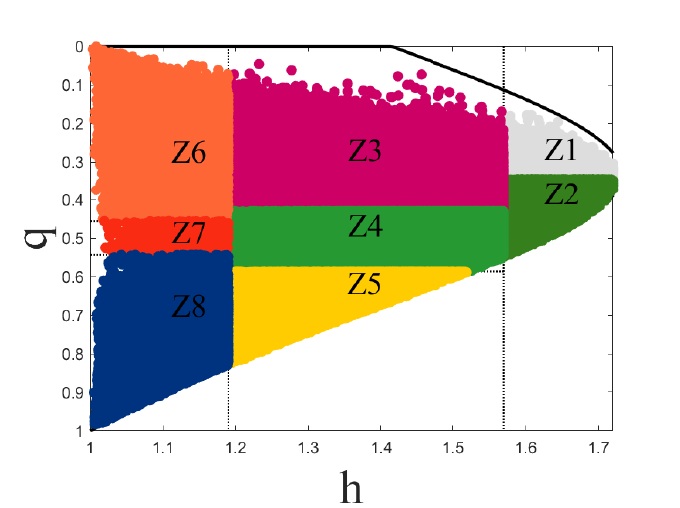
Figure 2. The scatter and classification threshold of h / q from San